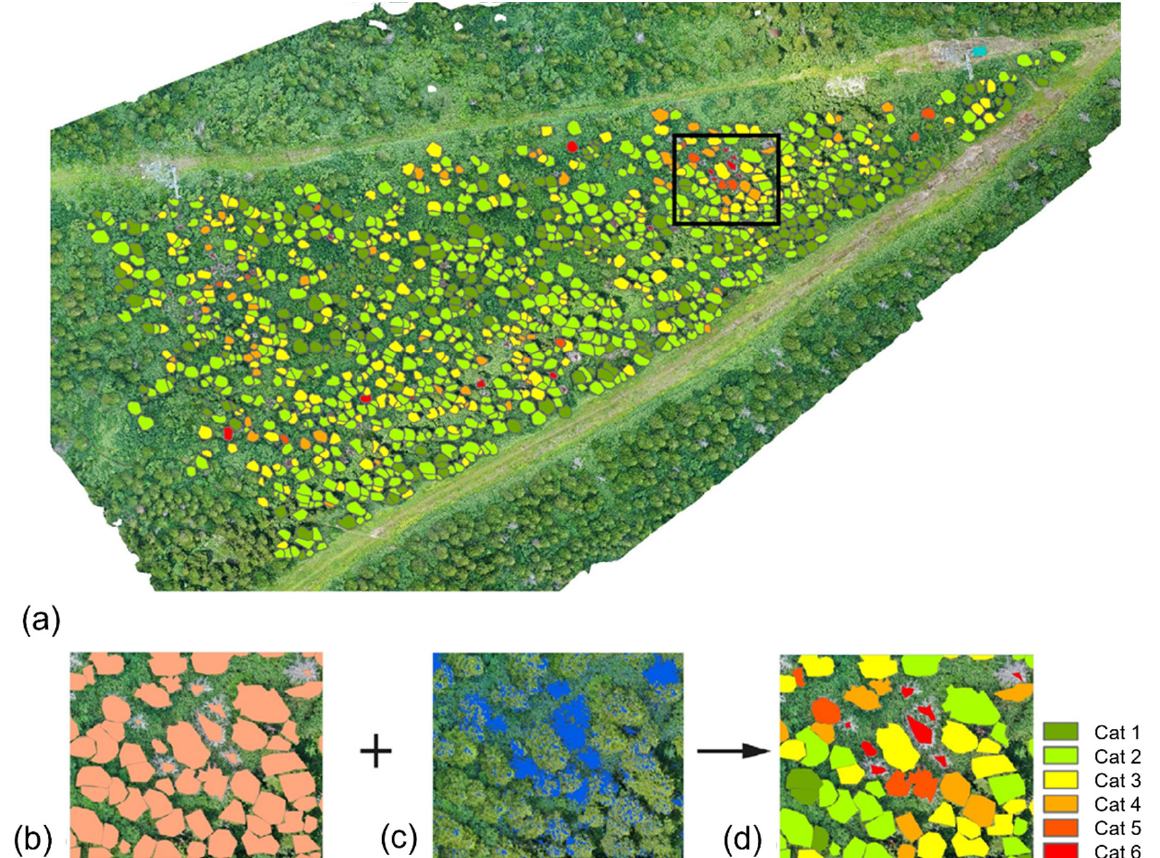
Figure 8. ( a ) Result of the model in Site 4. The black square inserted in this figure is used to depict the steps leading to tree damage categorization ( b – d ) , ( b ) single trees with polygons, ( c ) result of white detection, ( d ) result of the